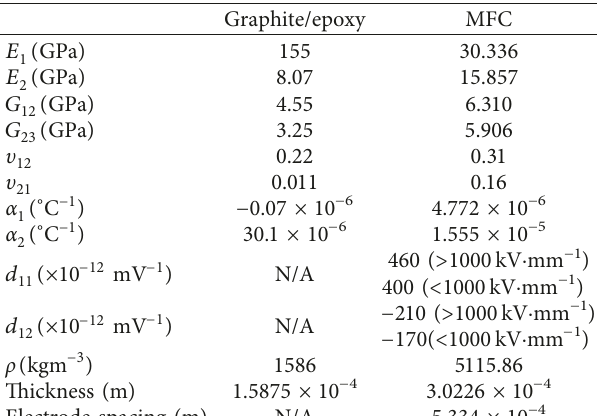
Table 1: Material properties and thicknesses of graphite/epoxy and MFC.